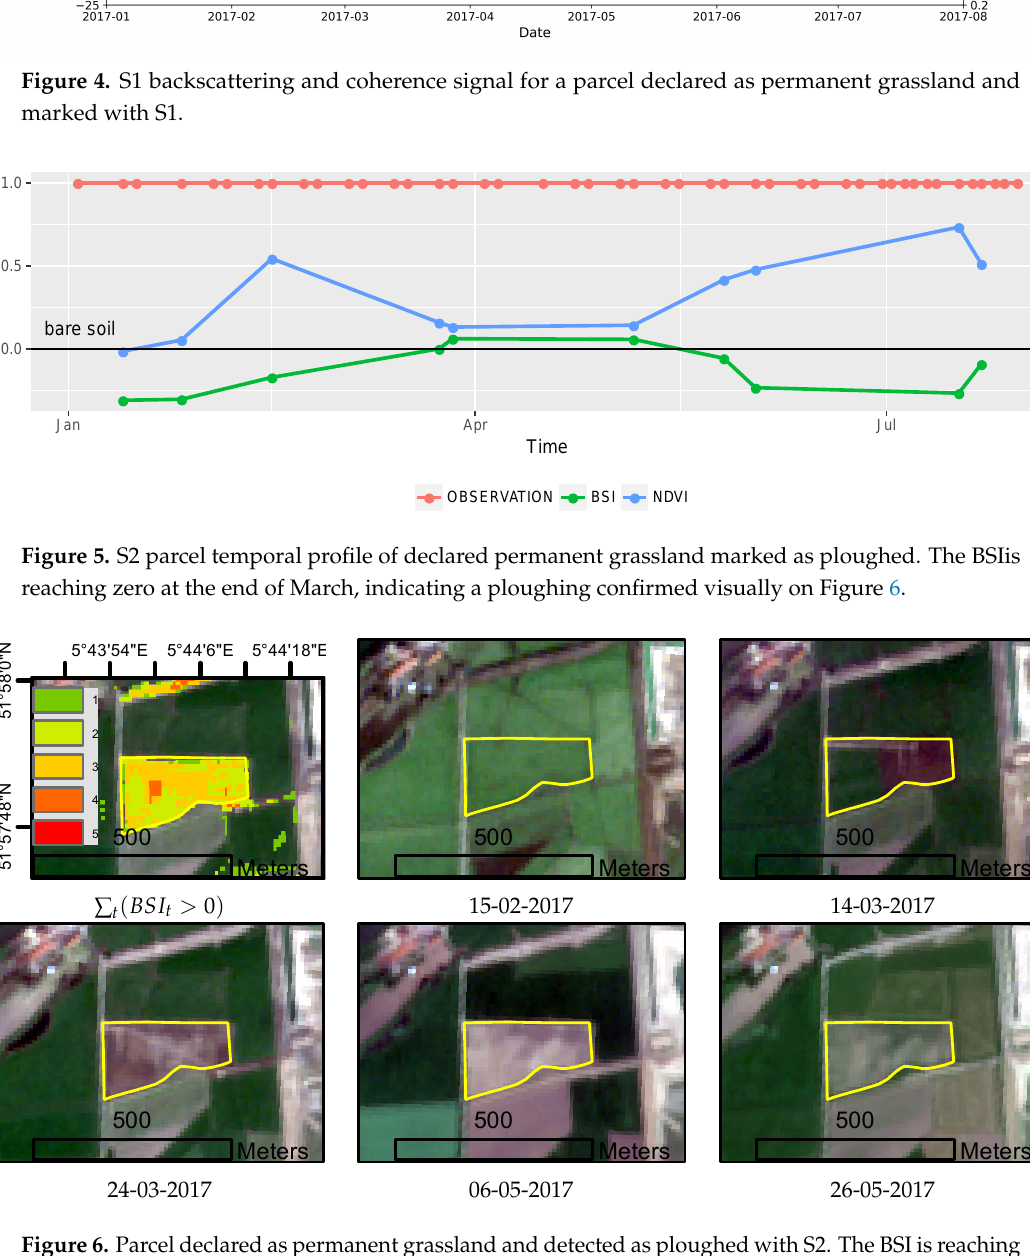
Figure 6. Parcel declared as permanent grassland and detected as ploughed with S2. The BSI is reaching zero at the end of March, indicating a ploughing here confirmed